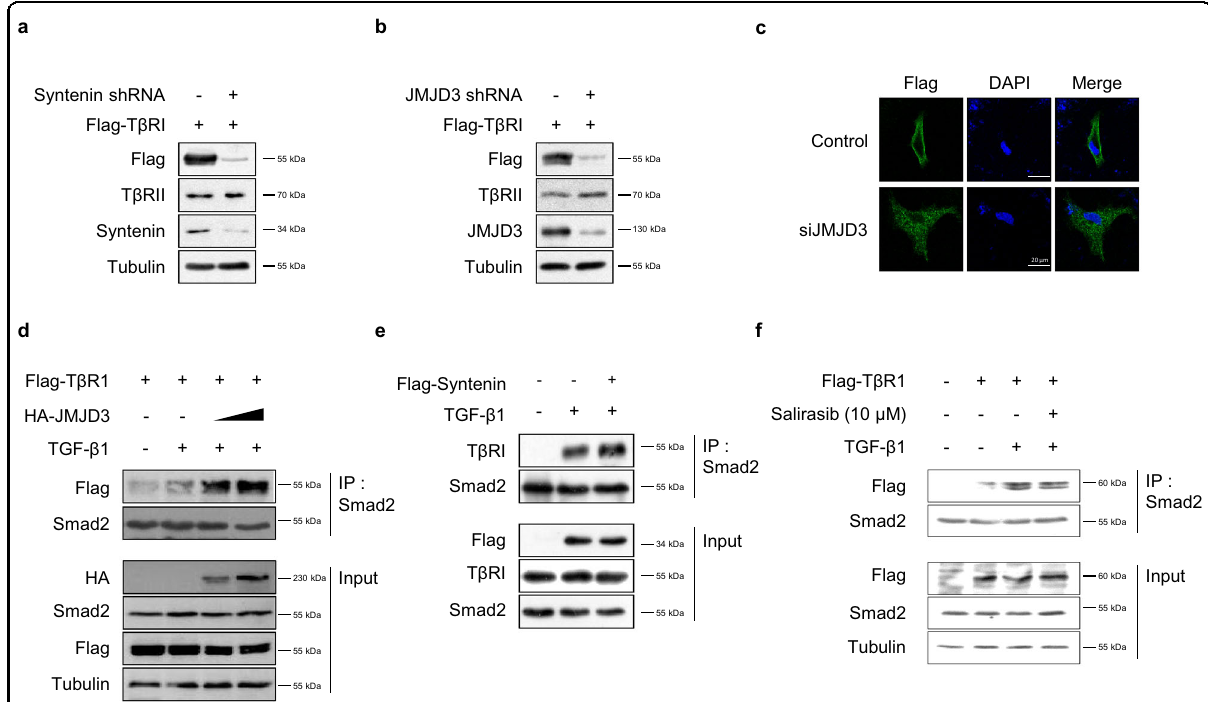
Fig. 6 JMJD3 promotes TGF- β -induced EMT by increasing syntenin-mediated formation of T β RI/Smad2/3 complex. a Expression of T β RI and T β RII protein expression in BZR cells transfected with Flag-T β RI and/or syntenin shRNA. b Expression of T β RI and T β RII protein expression in BZR cells transfected with Flag-T β RI and/or JMJD3 shRNA. c Immuno fl uorescence analysis of expression and localization of Flag-T β RI (green) in A549 cells in response to knockdown of JMJD3. DAPI-staining nuclei (blue) were also shown. Scale bar, 20 μ m. d Immunoprecipitates (IP) analysis of